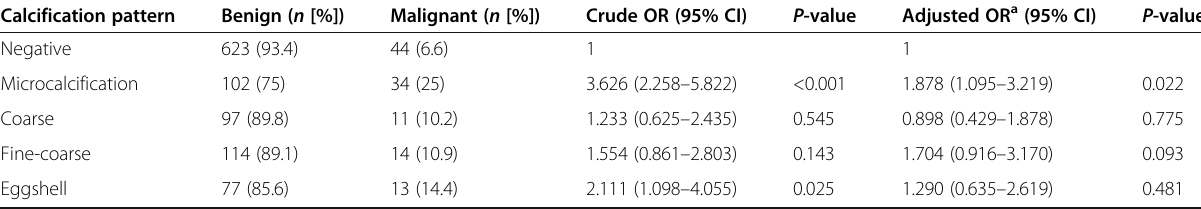
Table 1 Association between ultrasonic calcification patterns and cytology results of the thyroid nodules Calcification pattern Benign ( n